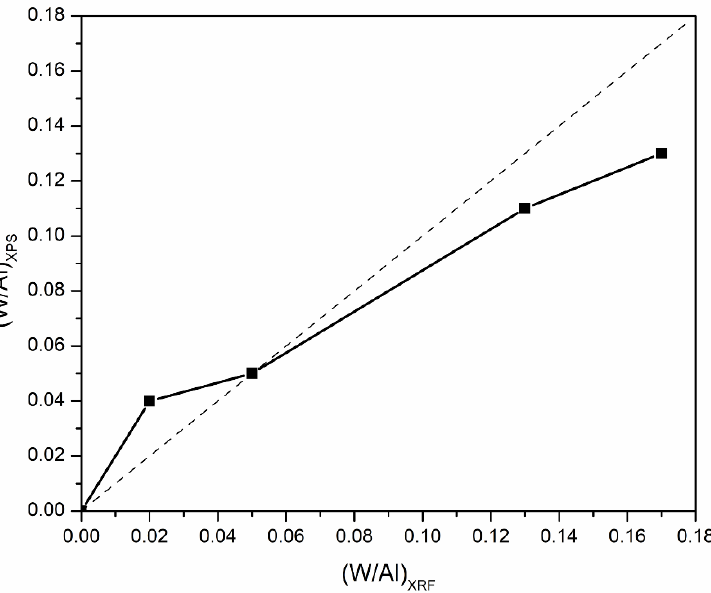
Figure 5. Surface versus bulk W/Al atomic ratios determined via XPS and XRF of WO 3 /Al 2 O 3 cata- lysts.